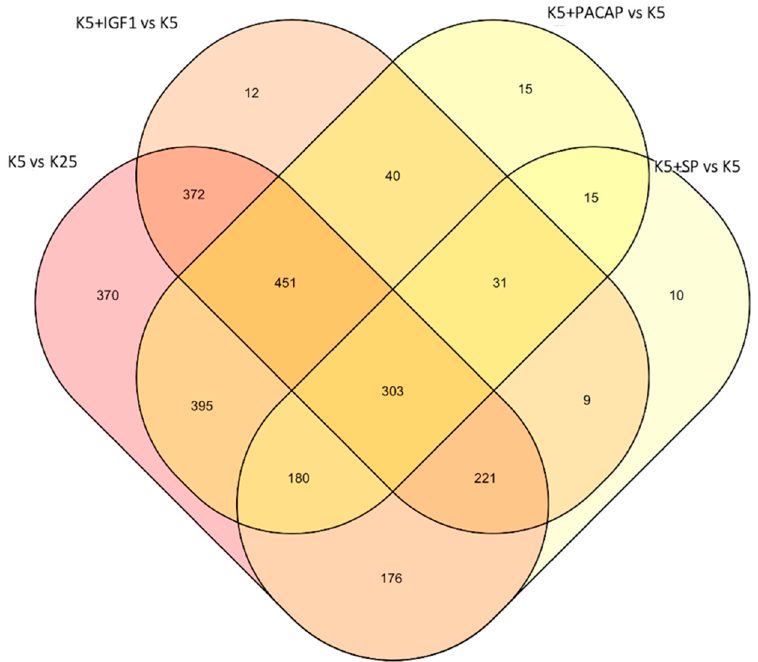
Figure 1. Venn diagram showing the number of genes differentially expressed in CGNs over time following induction of apoptosis (K5 vs. K25) or following rescue by SP, Pacap and Igf1. Of note, 262 genes (303 probes) were differentially expressed in all experimental conditions.